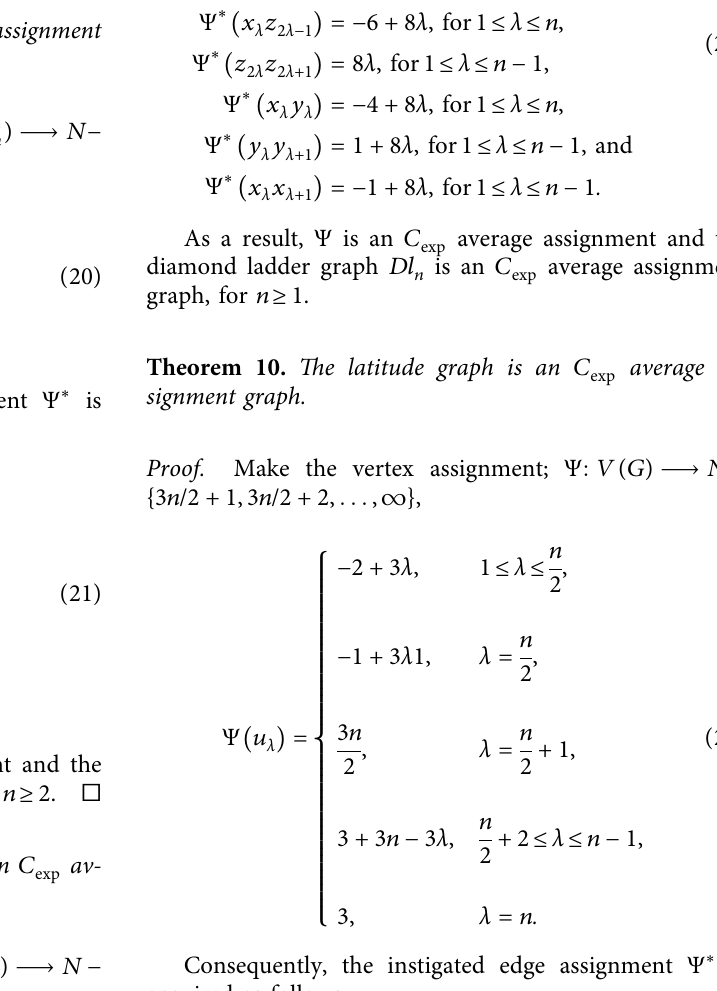
average assignment of the graph SL exp